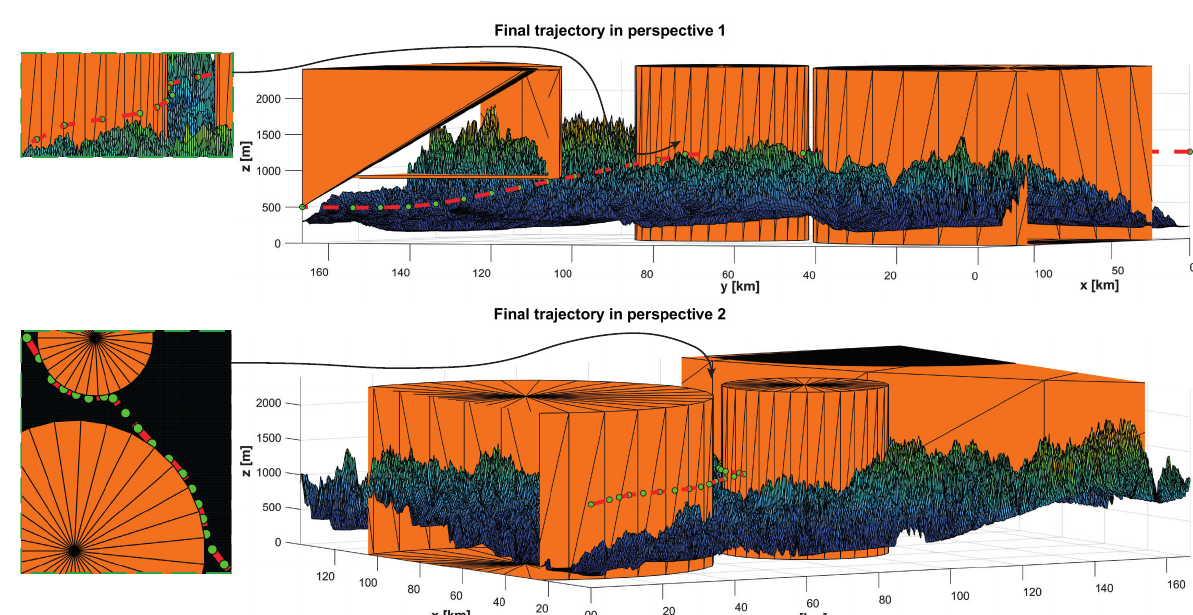
Figure 5. Final trajectory obtained by means of the recursive rewarding adaptive cell decomposition (RRACD) algorithm.